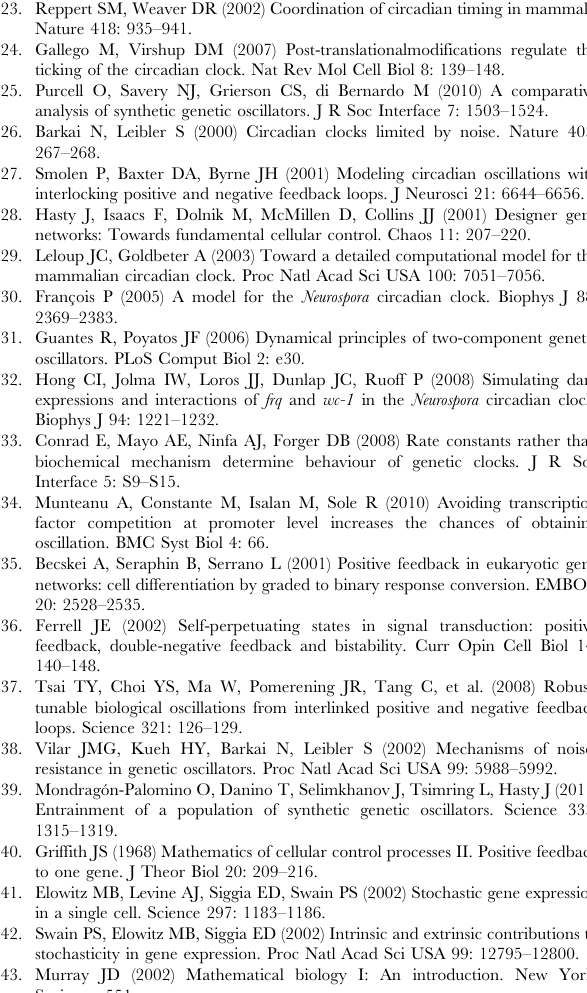
the peak of the oscillations ( u max is the value of the steady state in G ). (PDF) Figure S6 Hysteresis diagram. Hysteresis diagram depend- ing on C . The curve is the solution of the equation dA = dt ~ 0 , where C is assumed constant. The two solid lines in the diagram are the two stable steady states ‘‘high’’ and ‘‘low’’ as a function of C . The dashed line represents the unstable points in the diagram. (PDF) TableS1 Data points of Fig. 4I. (PDF) Table S2 Data points of locus Hopf bifurcation in reduced model (Fig. S4). (PDF) Table S3 Data points of locus of oscillations with less than 20% of correlation in the first period in the stochastic model (Fig. S4). (PDF) Text S1 The negative interaction does not produce an effective high nonlinearity. (PDF)